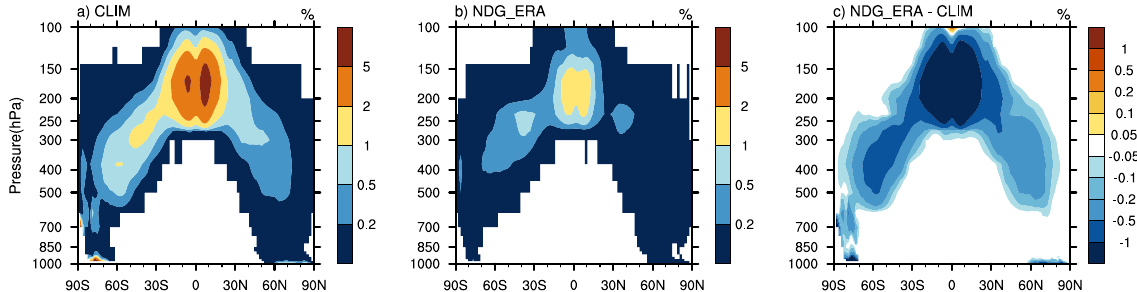
Figure 4. 5yr (2006–2010) mean, zonally averaged frequency of occurrence (unit: %) of homogeneous ice nucleation in the (a) CAM5 CLIM and (b) NDG_ERA_UVT simulations, and (c) the differences. The frequency of occurrence was calculated using an online nucleation counter which keeps track whether there is homogeneous ice nucleation happening at each model time step. Both simulations used present- day (PD) aerosol